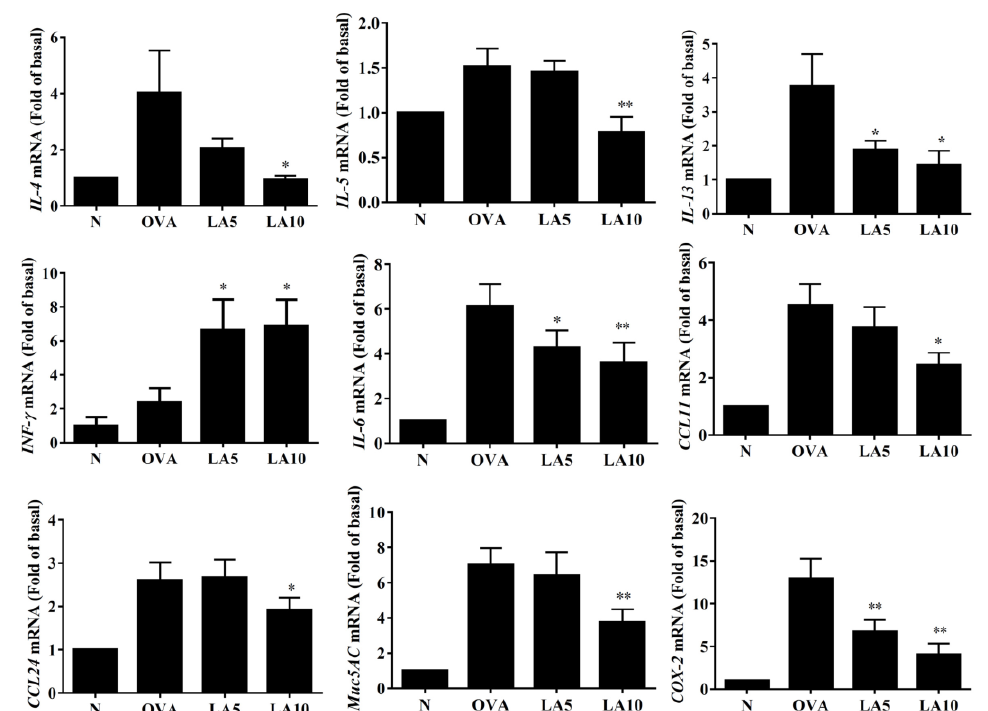
Figure 4. Effects of licochalcone A (LA) on the levels of cytokines and chemokines in BALF. The concentrations of ( A ) IL-4, ( B ) IL-5, ( C ) IL-13, and ( D ) CCL11 in BALF from normal (N) and OVA-stimulated (OVA) mice with or without licochalcone A (LA5-10) treatment were measured by ELISA. Three independent experiments were analyzed, and data were presented as mean ± SEM. * P < 0.05 compared to the OVA control group. ** P < 0.01 compared to the OVA control group.